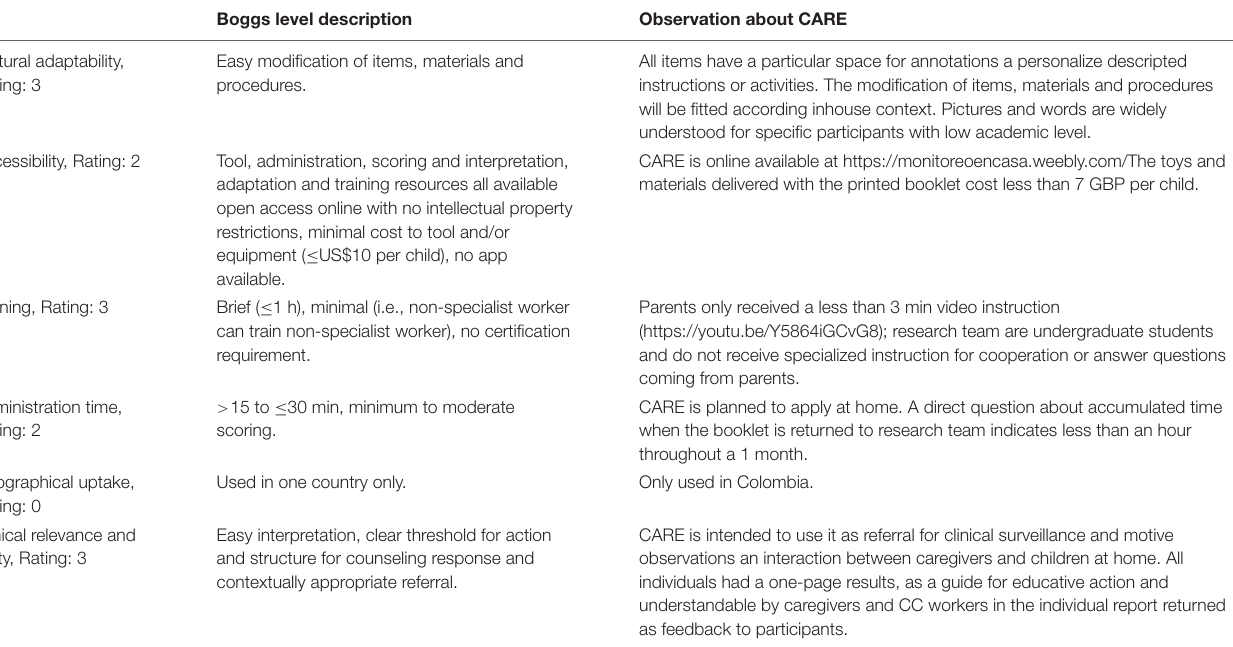
TABLE 7 | CARE characteristics according to early child development measurement tool accuracy and feasibility for use in routine programs criteria by Boggs et al. (2019). Boggs level description Observation about